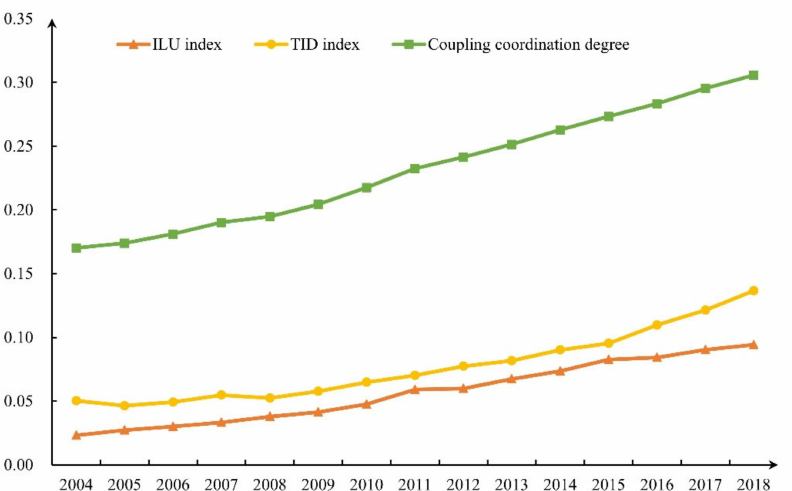
Figure 3. Time-series changes in ILU, TID index, and coupling coordination degree in China’s major tourist cities from 2004 to 2018.